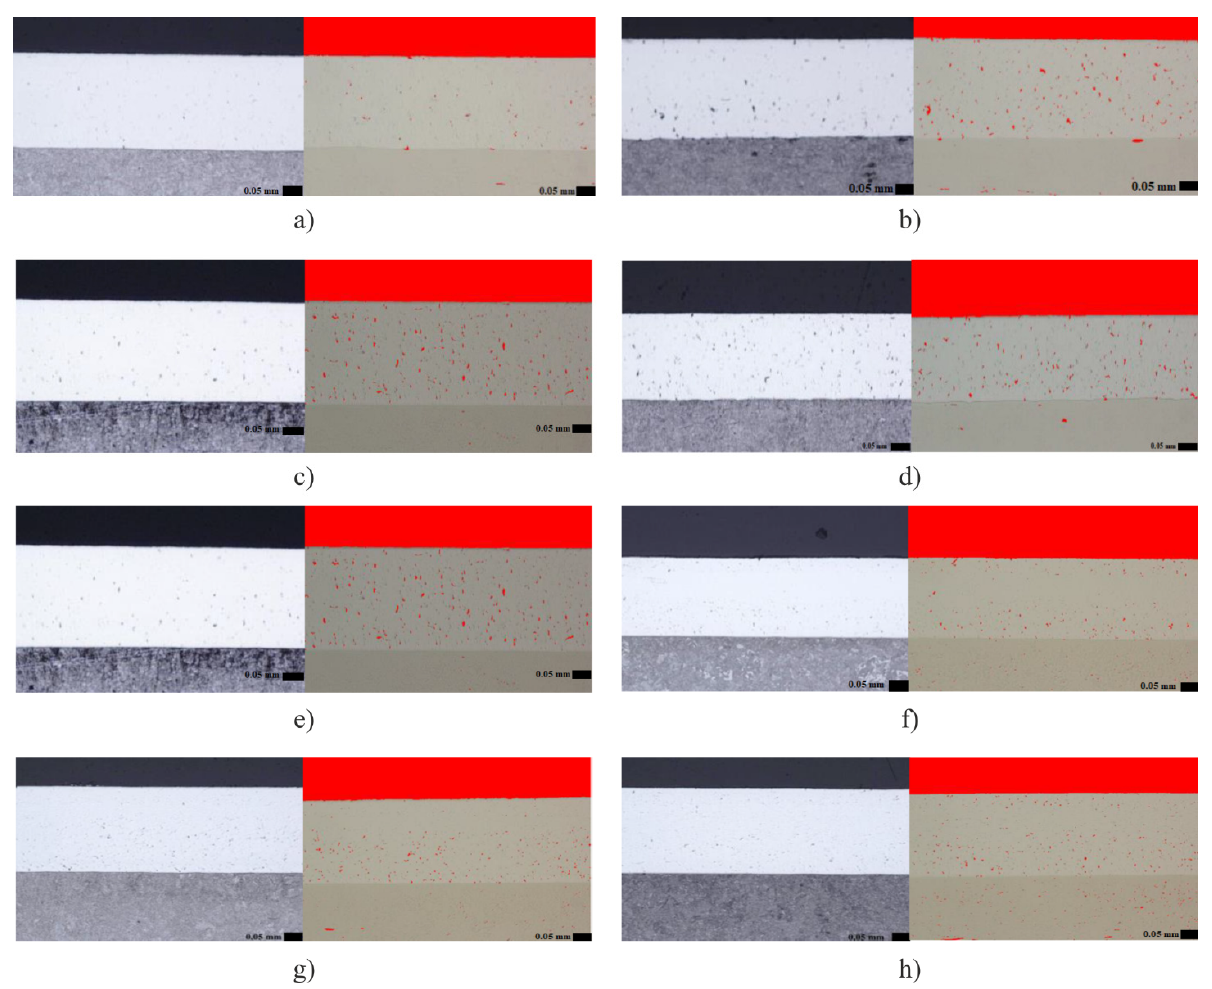
Figure 3. The microstructures and porosity of samples after grinding, ( a ) sample A1 (SG, v c = 30 m·s − 1 , v f = 0.13 mm·min − 1 ), ( b ) sample A5 (SG, v c = 30 m·s − 1 , v f = 0.64 mm·min − 1 ), ( c ) sample A6 (SG, v c = 40 m·s − 1 , v f = 0.13 mm·min − 1 ), ( d ) sample A10 (SG, v c = 40 m·s − 1 , v f = 0.64 mm·min − 1 ), ( e ) sample B1 (SiC, v c = 30 m·s − 1 , v f = 0.13 mm·min − 1 ), ( f ) sample B5 (SiC, v c = 30 m·s − 1 , v f = 0.64 mm·min − 1 ), ( g ) sample B6 (SiC, v c = 40 m·s − 1 , v f = 0.13 mm·min − 1 ), ( h ) sample B10 (SiC, v c = 40 m·s − 1 , v f = 0.64 mm·min − 1 ).